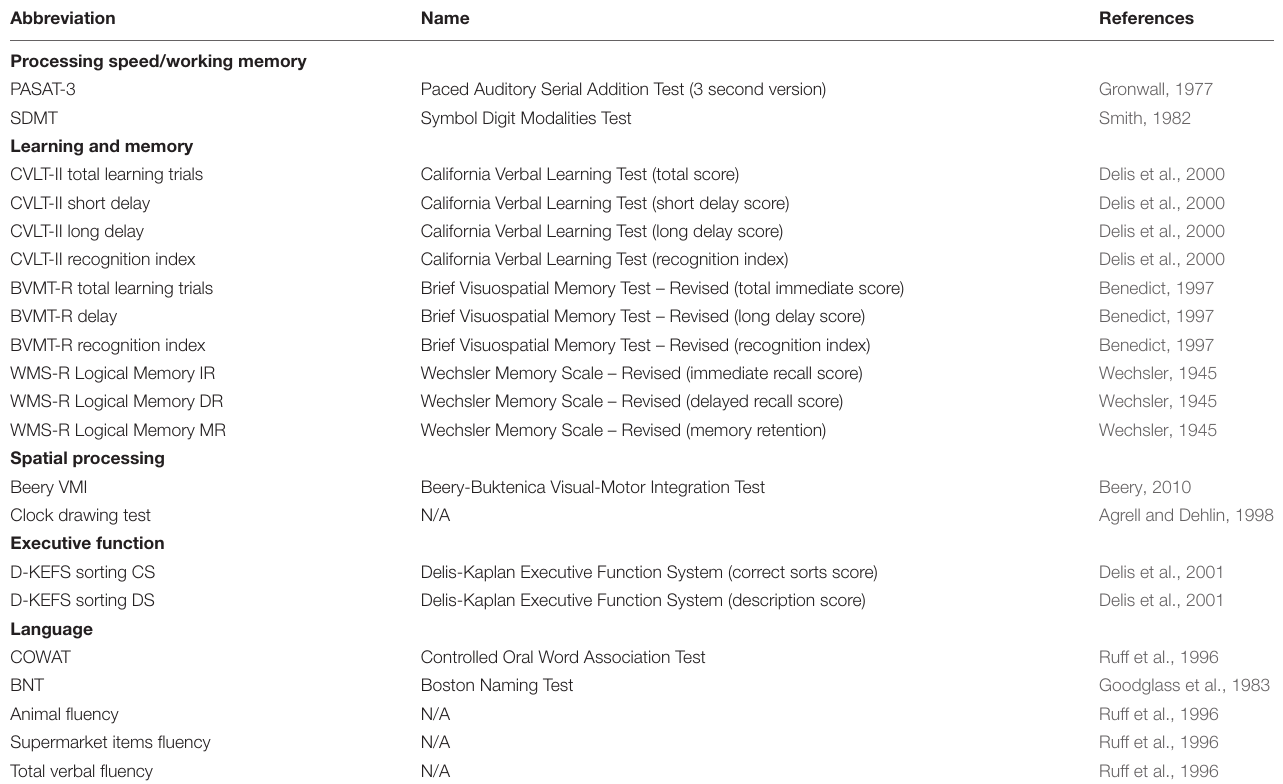
TABLE 1 | Cognitive domains and their respective